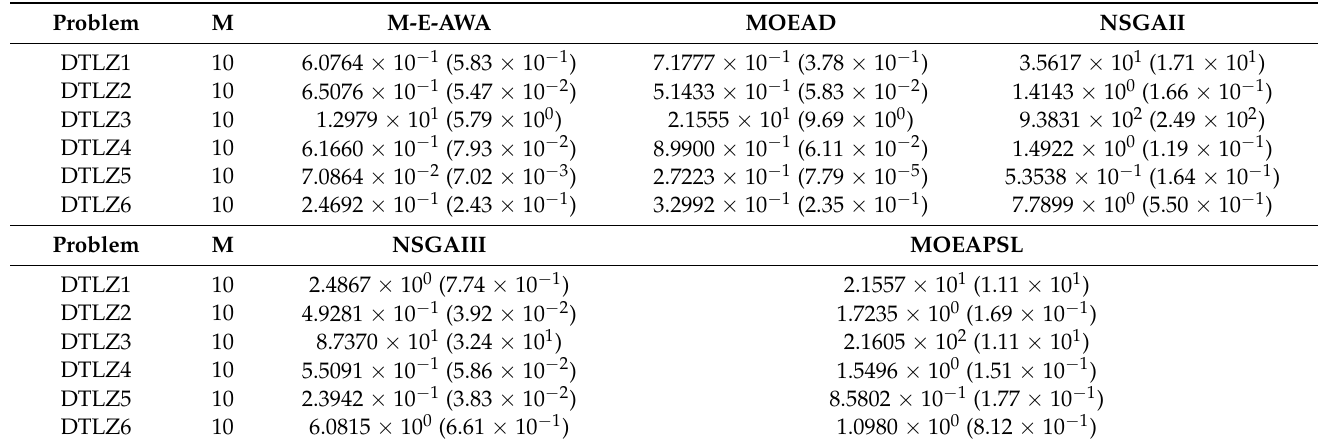
Table 4. Comparison of IGD values between M-E-AWA and contrast algorithms on DTLZ1– DTLZ6(The target number is 10).